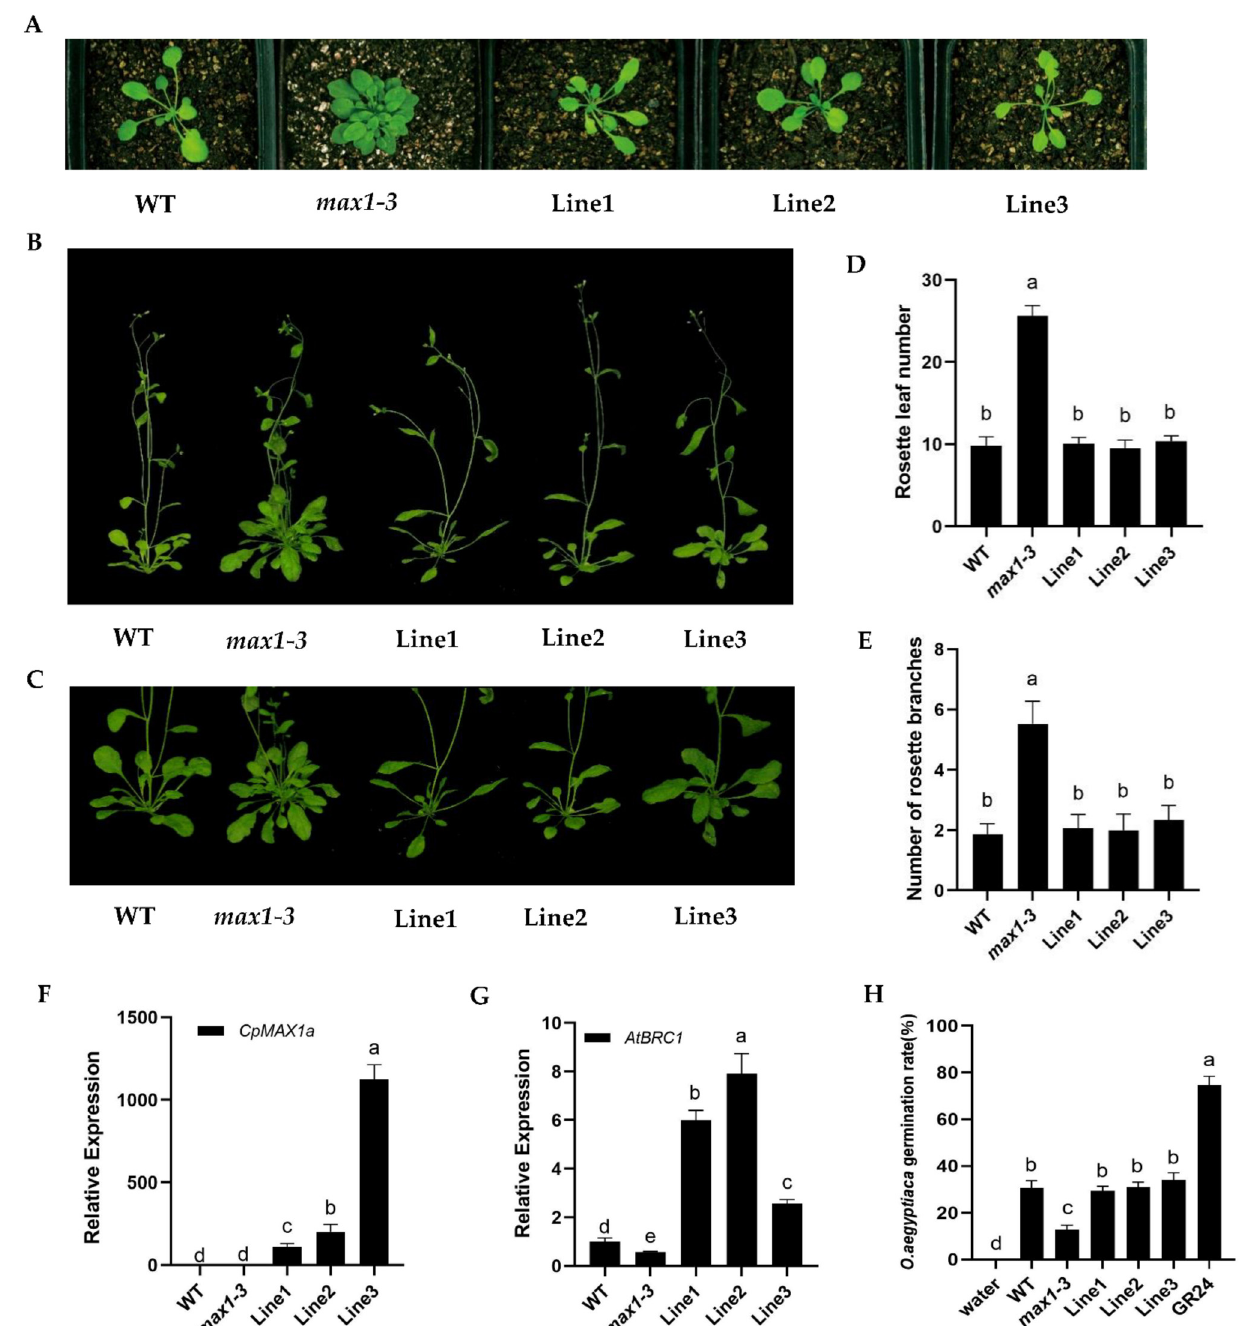
Figure 6. CpMAX1a overexpression restores the phenotype of the Arabidopsis branching mutant max1–3 . ( A ) Seedlings grown in soil for 2 weeks. ( B , C ) Branching phenotype of the WT, max1–3 mu- tant, and restored lines 1–3 grown in soil for 5 weeks. ( D ) Number of rosette leaves and ( E ) number of rosette branches in the WT, max1–3 mutant, and CpMAX1a complementation lines 1–3. ( F ) Expression levels of CpMAX1a and ( G ) expression levels of AtBRC1 in the WT, max1–3 mutant, and CpMAX1a restored lines 1–3. ( H ) The extraction solution of CpMAX1a restored lines induced Orobanche seeds germination experiment; water as a negative control, and GR24 as a positive control. Data shown are the mean ± SD of three biological replicates. Different lowercase (a–e) above the bars indicates significant differences ( p <